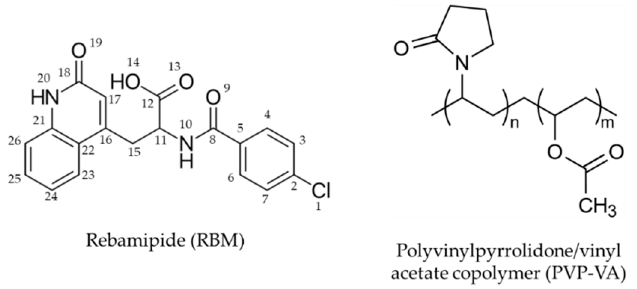
Figure 2. Chemical structures of rebamipide with atom numbering and polyvinylpyrrolidone/vinyl acetate copolymer (Kollidon ® VA64).